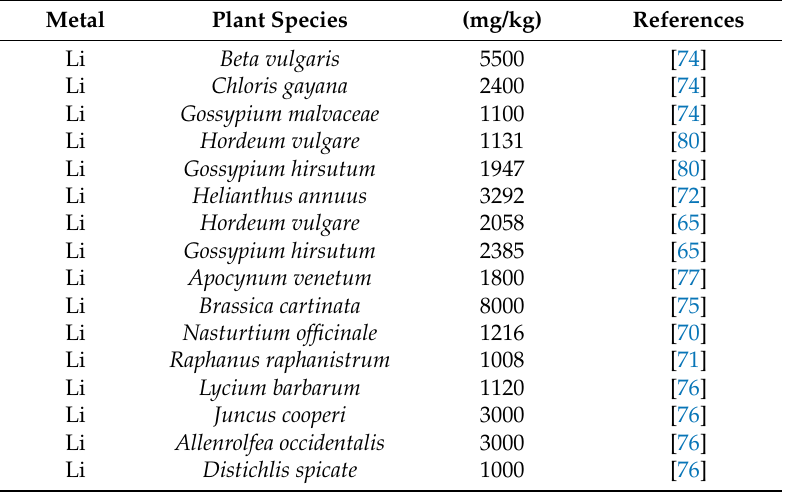
Table 2. Some recorded levels of Li in plants from several Li plant tolerance